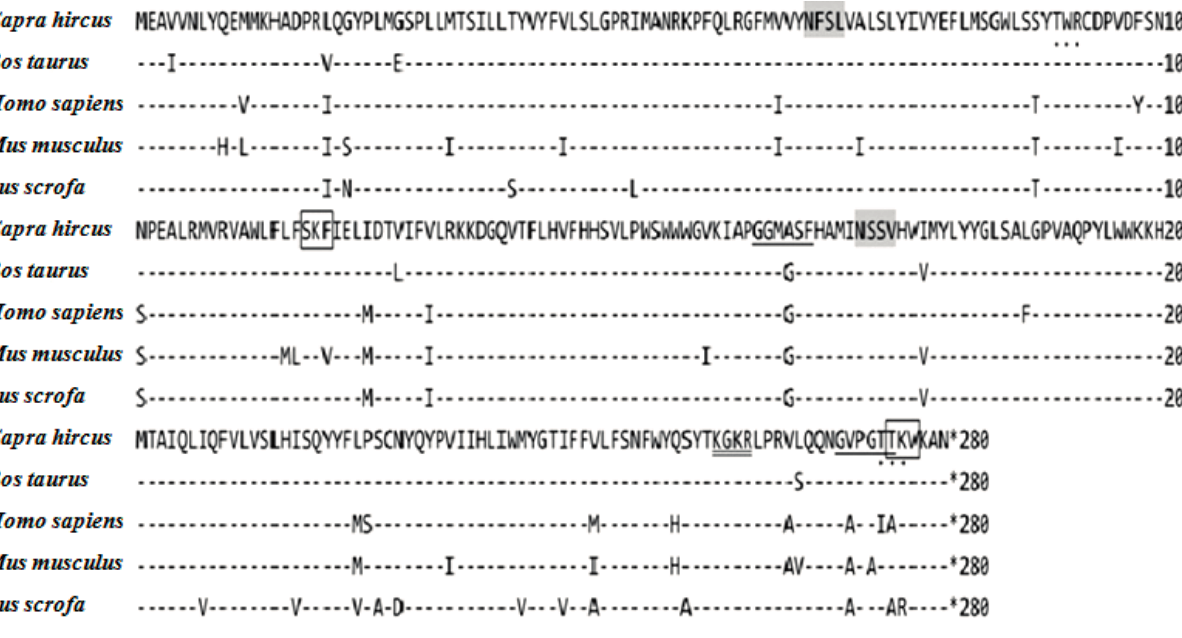
Figure 2. Deduced amino acid sequence and the active sites of ELOVL1. Alignment of amino acid sequences of capra hircus (KF549985), bos taurus (NM001034703.2), sus scrofa (NM001167647.2), homo sapiens (NM022821.3), and mus musculus ELOVL1 (NM001039176. 2). Predicted N -glycolsylation sites are shaded gray. Protein kinase C phosphorylation sites are indicated as dots. N -myristoylation sites are underlined. Amidation sites are marked by double underlines. Microbody C-terminal targeting signals are boxed.